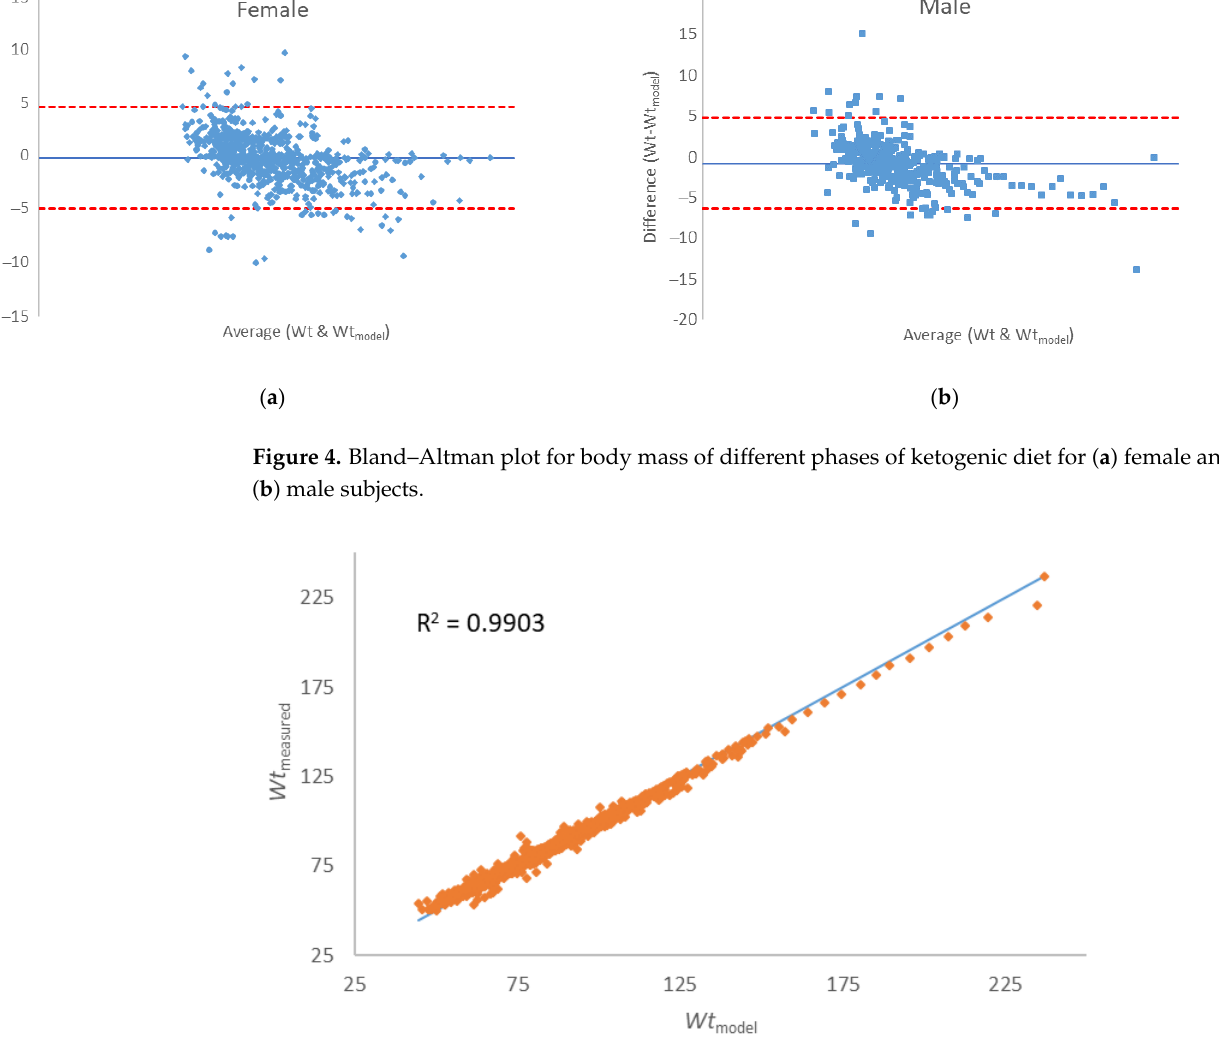
Figure 5. Compatibility of estimated body masses with the modified Wishnofsky equation ( Wt ) during the reduction ketogenic diet and established body masses at the end of the program.